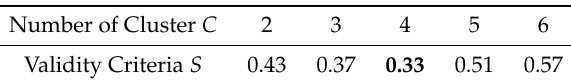
Table 3. Validity